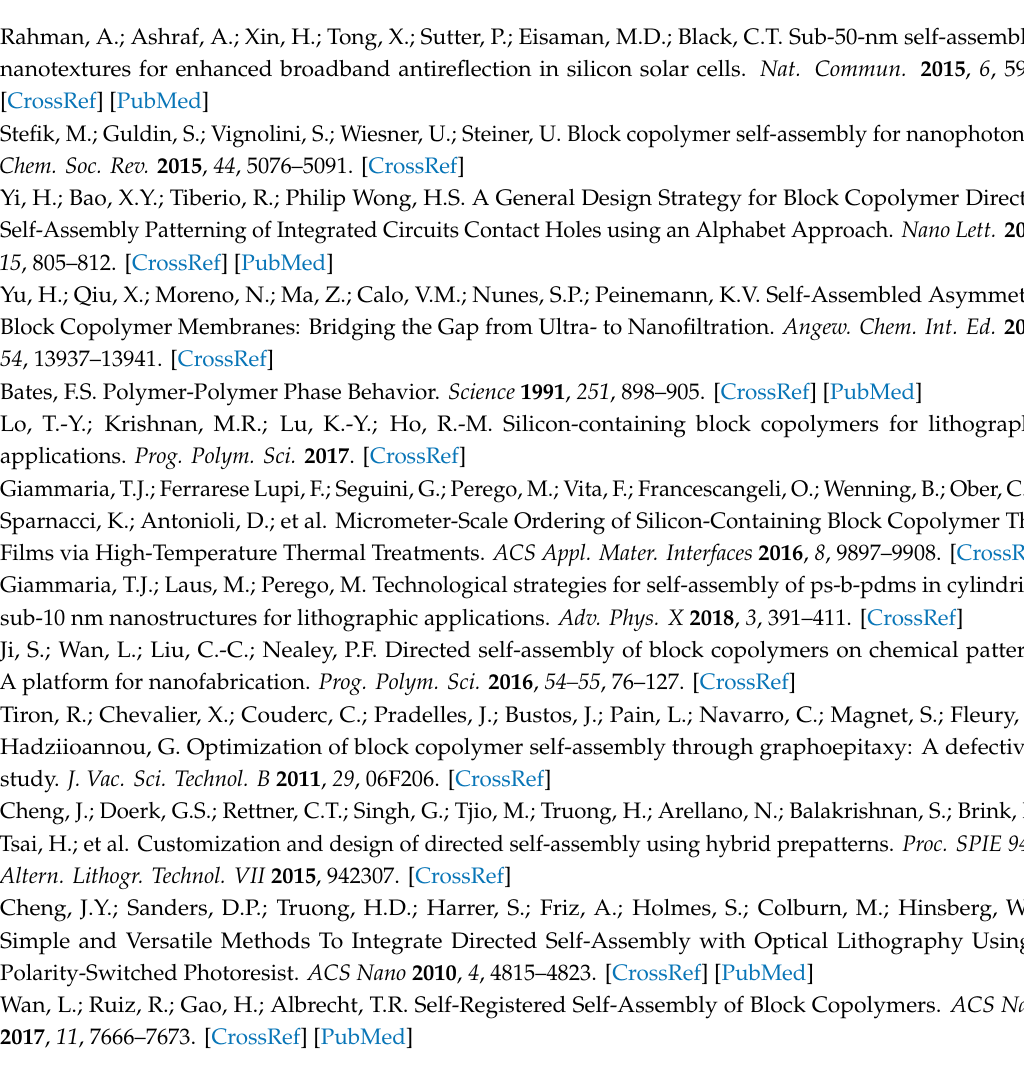
Figure S1: Evolution of the TEOS lines etching as function of the HF etching